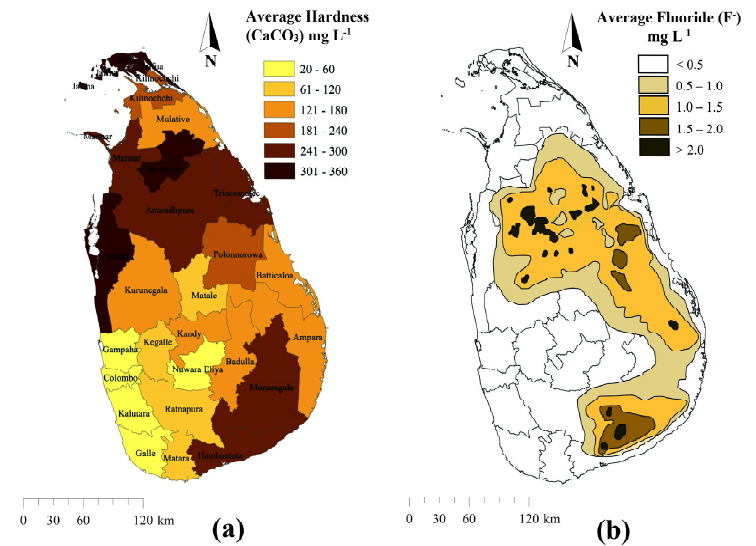
Figure 3. ( a ) Average hardness at CaCO 3 [37] and ( b ) fluoride distribution [46] in groundwater in each district in Sri